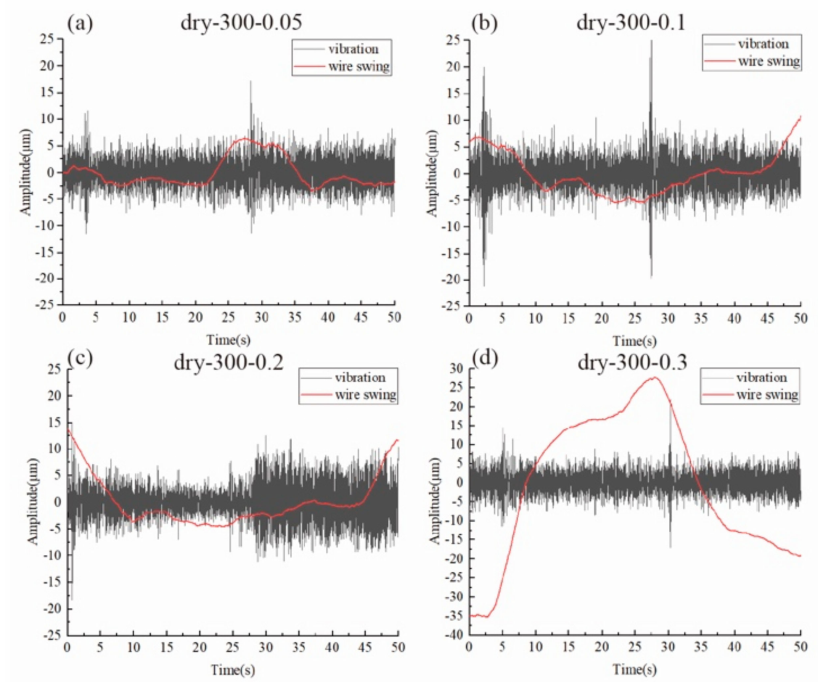
Figure 5. The wire vibration and wire swing motion during dry cutting.